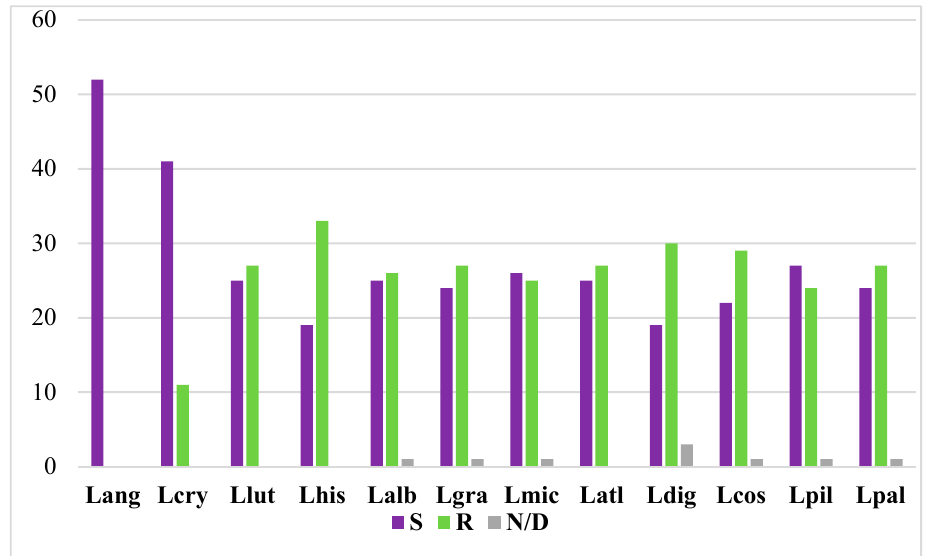
Figure 3. Representation of ‘single’ (S) and ‘repetitive’ (R) BAC clones in 11 lupin genomes. Lang, L. angustifolius (reference species). Lcry, L. cryptanthus . Llut, L. luteus . Lhis, L. hispanicus . Lalb, L. albus . Lgra, L. graecus . Lmic, L. micranthus . Latl, L. atlanticus . Ldig, L. digitatus . Lcos, L. cosentini . Lpil,